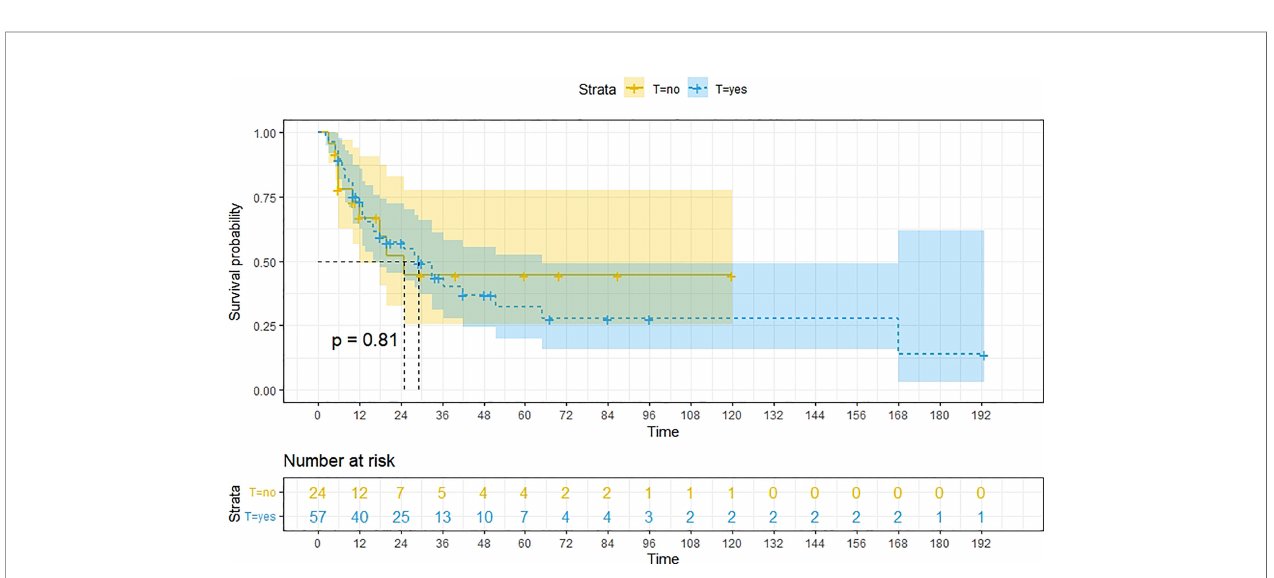
FIGURE 6 | Kaplan-Meier survival curves for OS in patients of no Lymphadenectomy and Lymphadenectomy. The median OS for them are10m, 33m respectively.